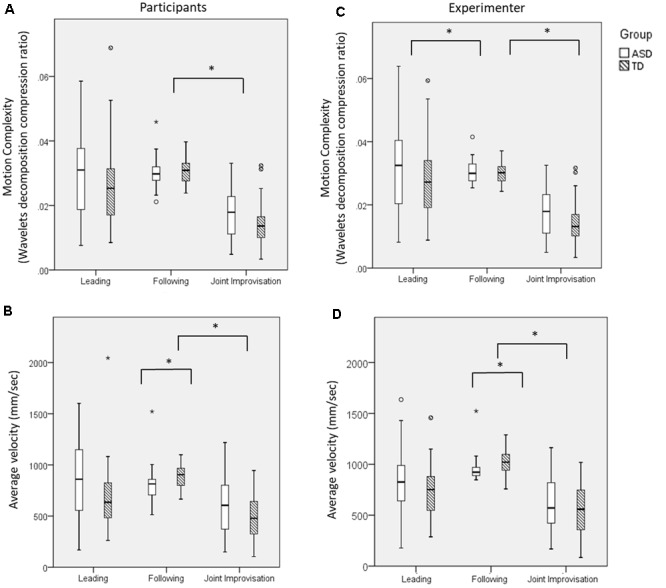
Basic motor characteristics in the MG. (A) Participants’ motion complexity differed significantly across rounds, but did not differ between groups. (B) Participants’ motion velocity was slower for all participants during JI, compared with Leading or Following rounds. ASD participants moved more slowly when following an expert improviser. (C) The experimenter’s motion complexity did not differ significantly across both groups within each round, though there was a significant effect of round which mirrored the motion patterns of participants. (D) The experimenter’s average velocity similarly differed across rounds, mirroring the motion patterns of participants; the experimenter’s motion was faster when playing with the TD participants, but did not differ across groups in other rounds. Large asterisks represent p < 0.05 group differences. Boxplots: the solid line represents the median of the distribution; the outlines of the box represent the interquartile range, or 25th–75th percentiles; the whiskers represent the upper and lower quartiles, excluding outliers; small points and asterisks represent outliers and extreme outliers, respectively.